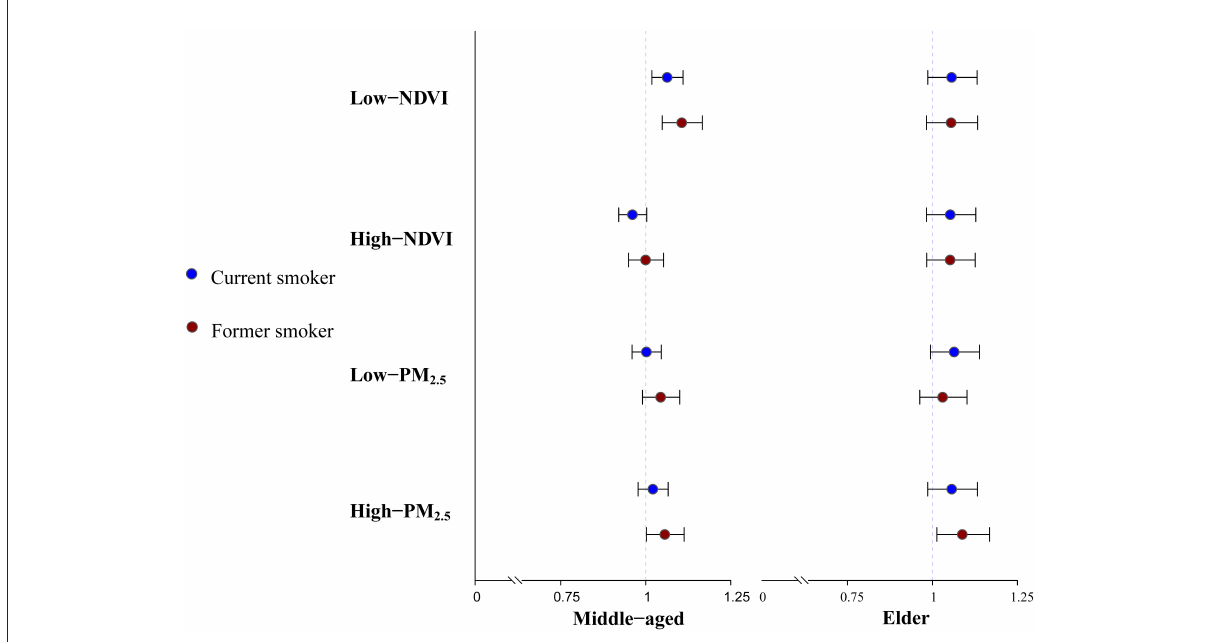
FIGURE3 Single environmental factor analysis among mid-age and elder group.